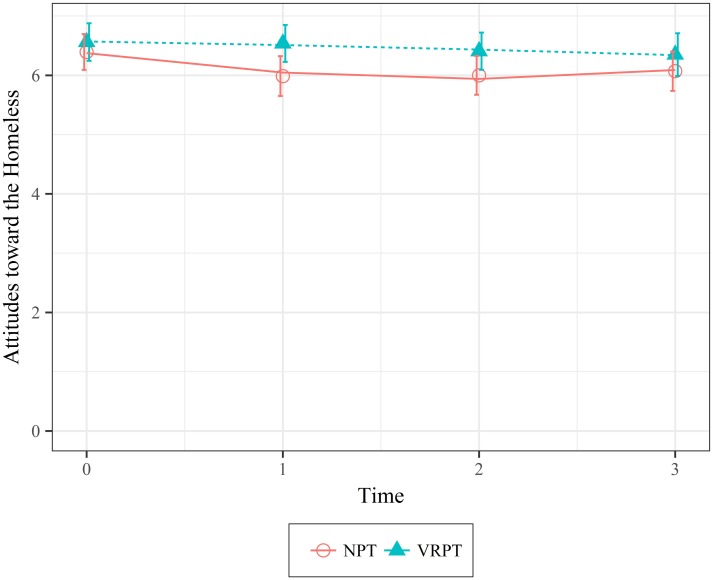
Mean values of attitudes toward the homeless as a function of condition over time.Error bars represent 95% Confidence Intervals.